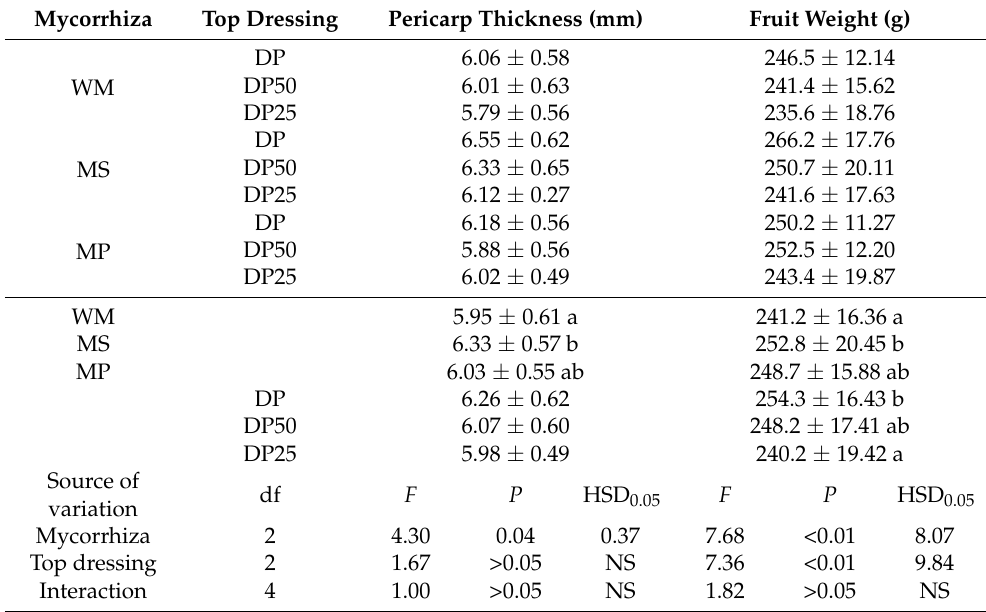
Table 2. Biometric characteristics of sweet pepper marketable fruits; on average across three years (2014–2016).